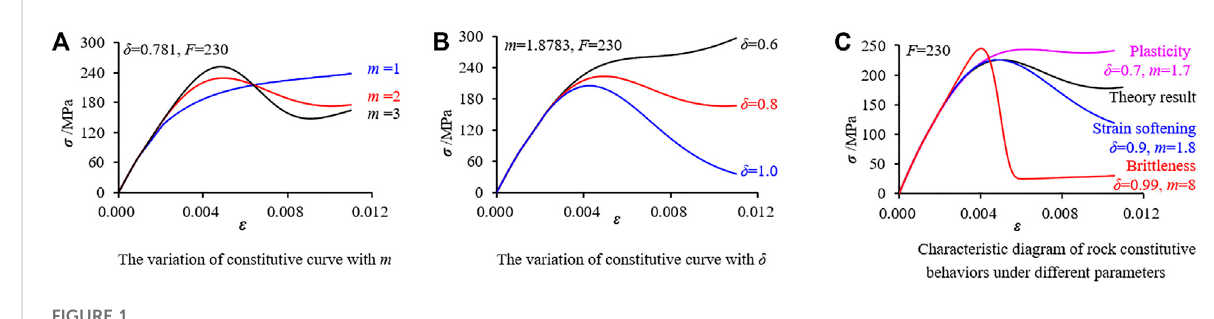
FIGURE 1 Theoretical analsis of constittive curves with different